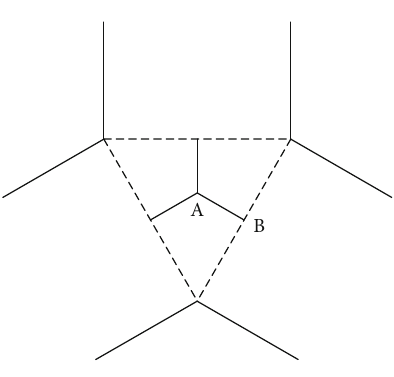
Figure 4: Sectional view of the node.